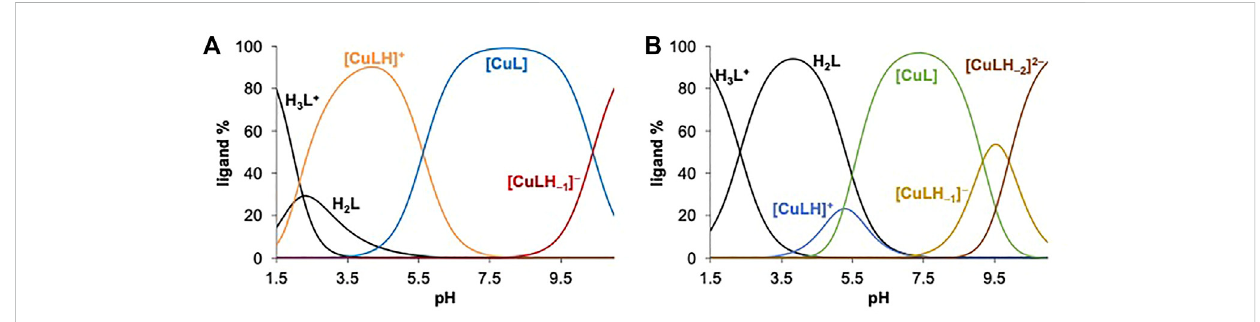
FIGURE 4 Concentrationdistributioncurvescalculatedforthe (A) Cu(II) ‒ L 1 (1:1)and (B) Cu(II) ‒ L 6 (1:1)systems.[ c Cu(II) = c L =50 μ M; t =25.0 ° C; I =0.10 M(KCl); 30% (v/v)